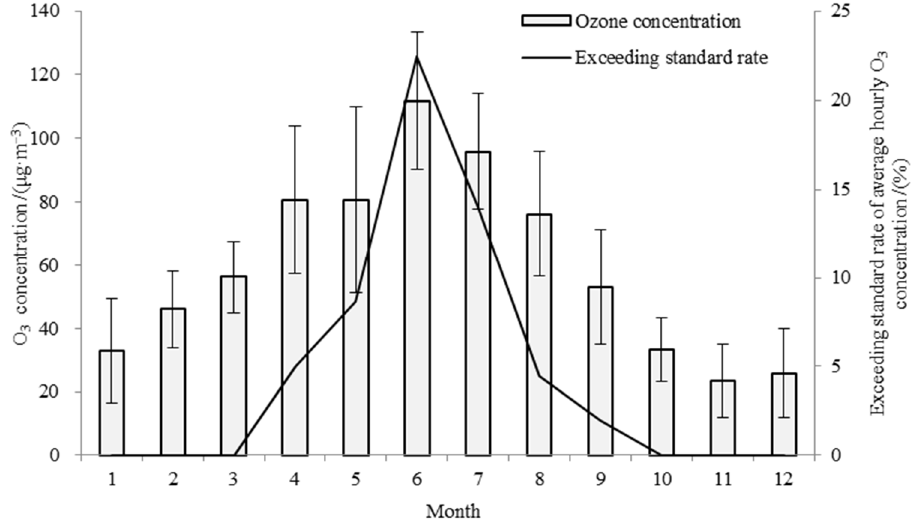
Figure 2. Annual variation of monthly average O 3 concentration.